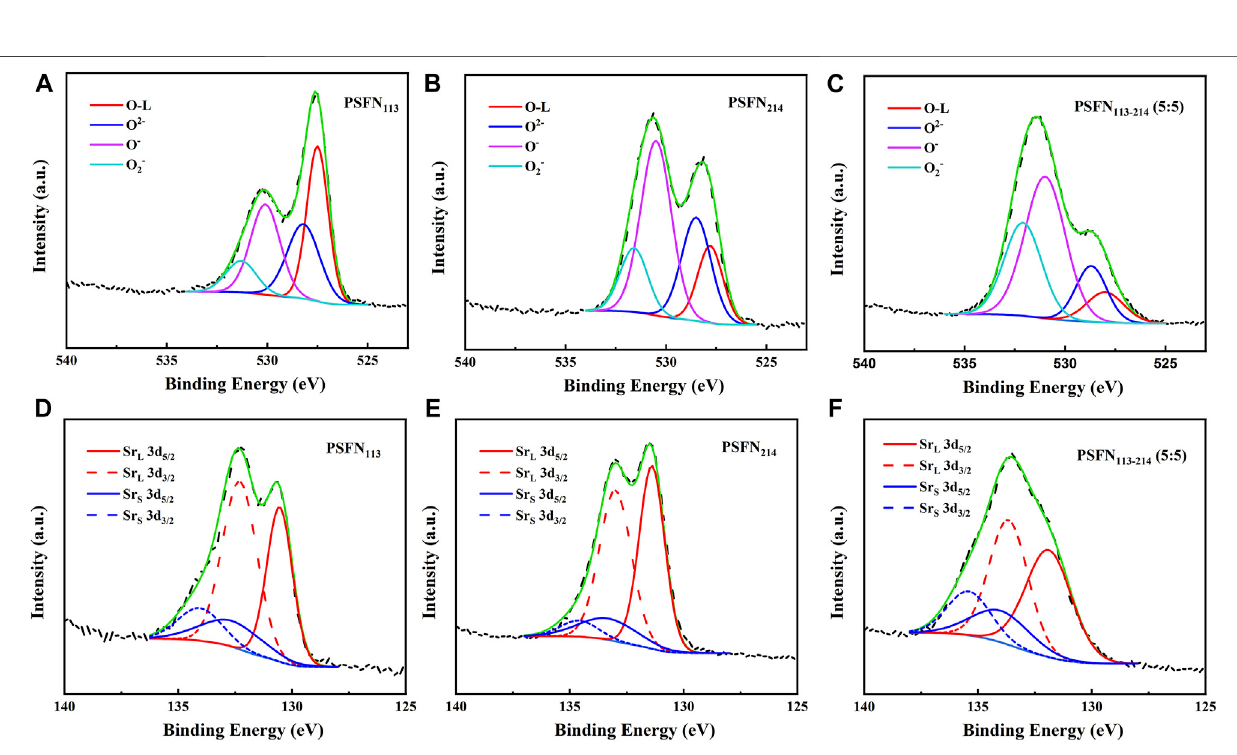
Frontiers in Chemistry |